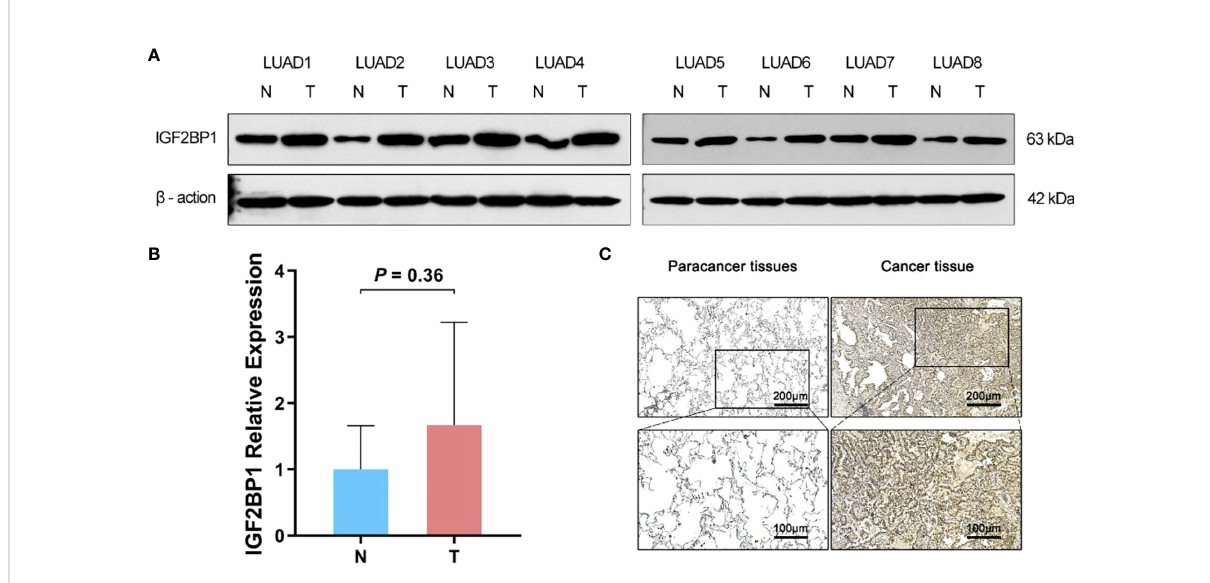
FIGURE 5 The difference expression of IGF2BP1 in cancerous and para-cancerous tissues. (A) Western Blot detected the expression of IGF2BP1 in cancerous and para-cancerous tissues. (B) Real-time PCR detected the expression of IGF2BP1 in cancerous and para-cancerous tissues. Data are presented as mean ± S.D. P -value was calculated by a two-sided unpaired Student ’ s t-test. (C) Immunohistochemistry detected the expression of IGF2BP1 in cancerous and para-cancerous